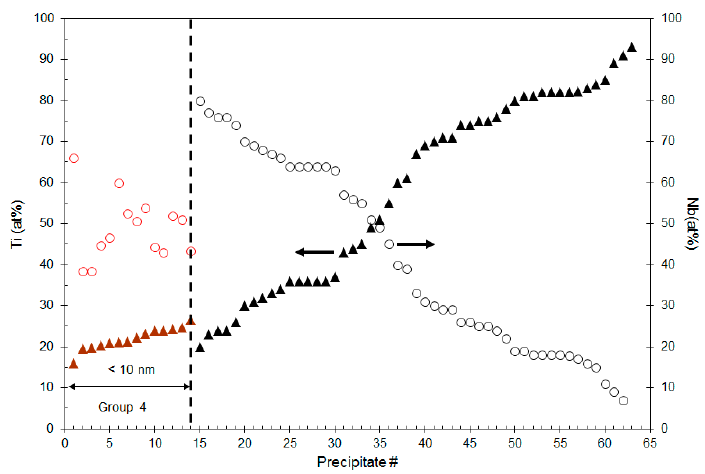
Figure 5. Amount of Ti (solid triangles) and Nb (open circles) for selected precipitates measured by EDX analysis.